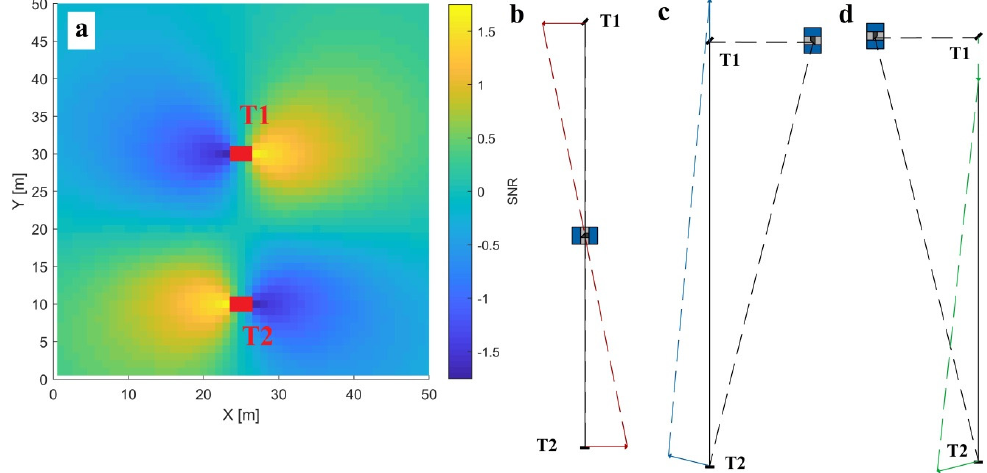
Figure 14. The SNR ratio of the length consistency test for x 1n ( a ), with the least ( b ) and the most ( c , d ) sensitive TLS positions (top view); line and arrows: red—rotated length, blue—extended length, and green—contracted length.